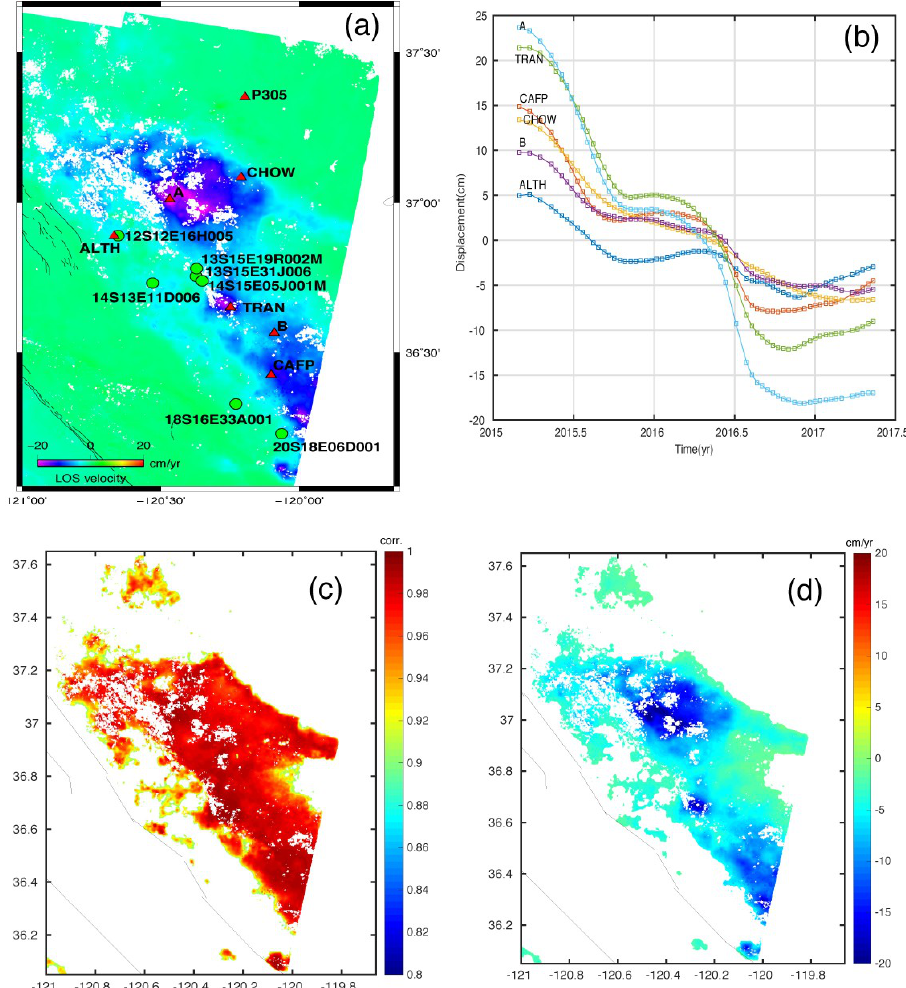
Figure 10. ( a ) Zoom‐in view of LOS subsidence velocity overlaid with GPS stations and selected pixel location (A, B) (red triangles) and well locations (green circles). GPS station P305 is the reference location used in the InSAR time series analysis. ( b ) InSAR LOS time series from the selected pixel locations and GPS stations. ( c ) Masked temporal correlation coefficient where the correlation is above the selected threshold (0.9). ( d ) LOS subsidence velocity masked based on (c). All areas that undergo subsidence are captured, suggesting very similar subsidence time histories in the subsiding areas.